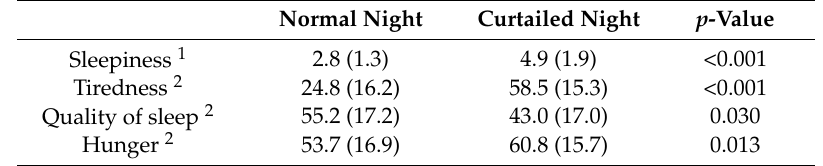
Table 3. Effects of curtailed sleep on self-reported sleepiness, tiredness, quality of sleep and